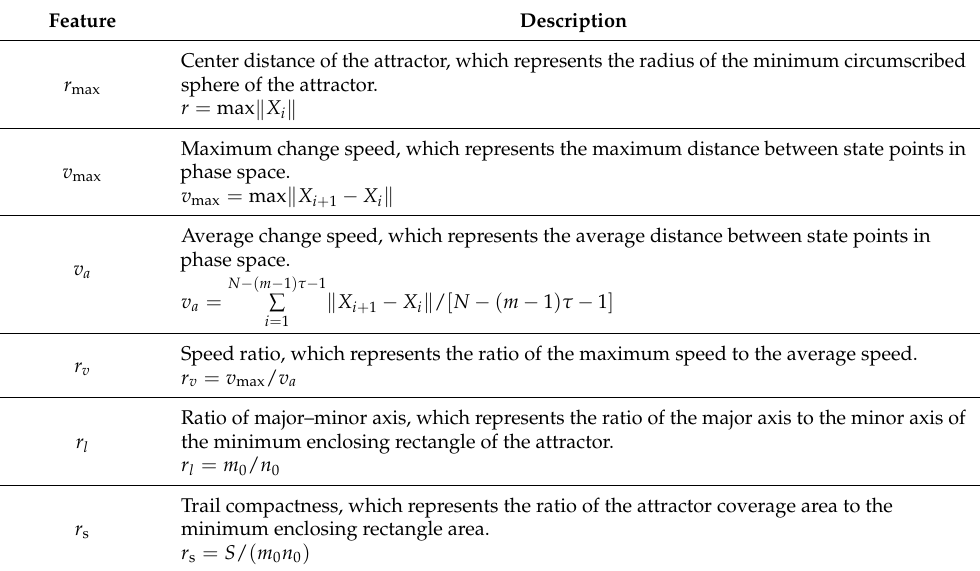
Table 1. Features from the shape of the attractor trail, where m 0 and n 0 are the major and minor axis of the minimum enclosing rectangle of the attractor, respectively, and S is the coverage area. Feature Description r